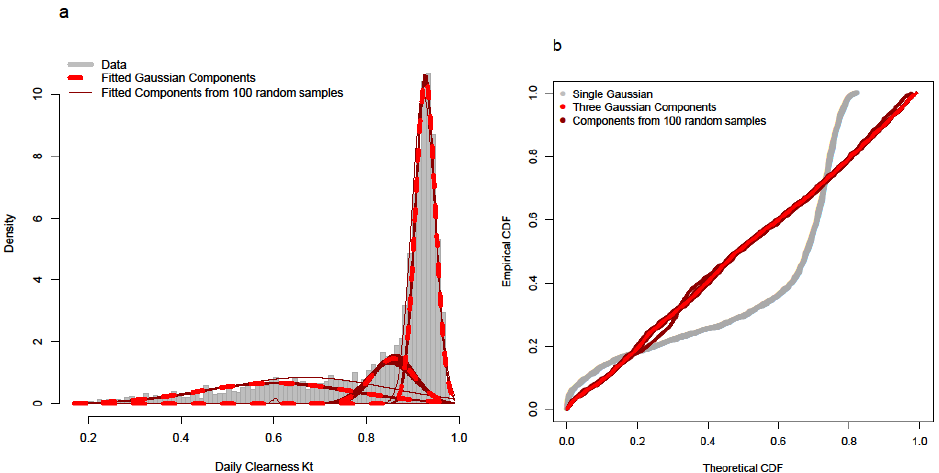
Figure 8. Daily Clearness indices ( K t ) with three-component Gaussian mixture in red, 95% confidence intervals in dark red, and single Gaussian in grey, represented as ( a ) distribution densities; and ( b ) quantile-quantile plots.